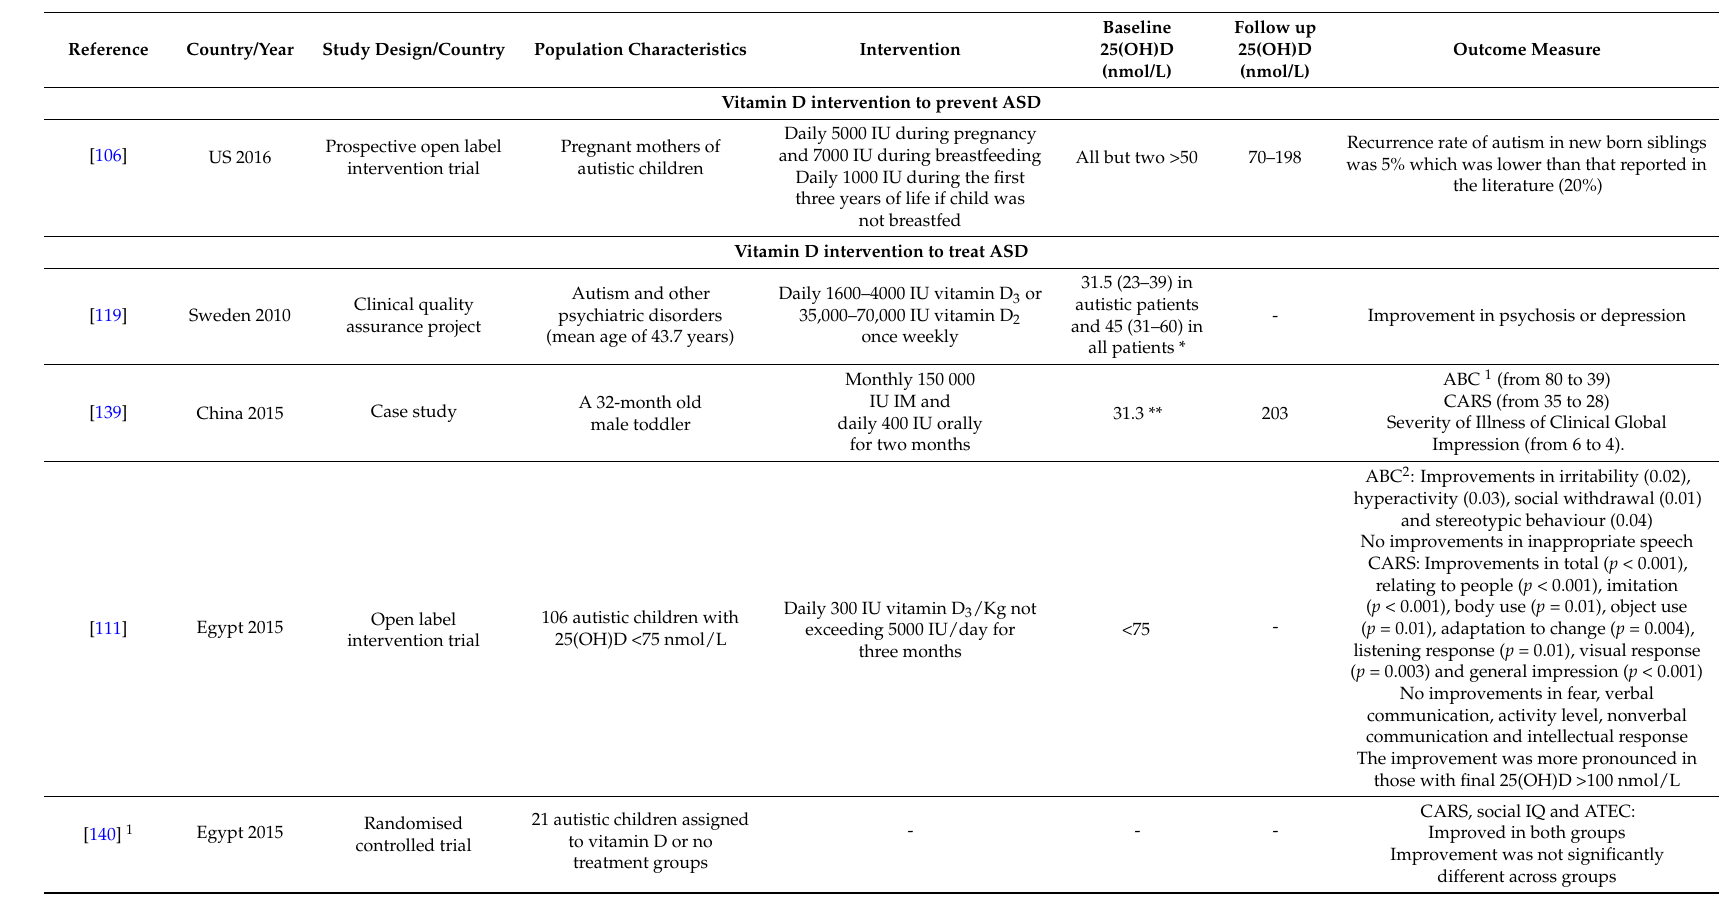
Table 4. Vitamin D interventions to prevent or treat Autism Spectrum Disorder